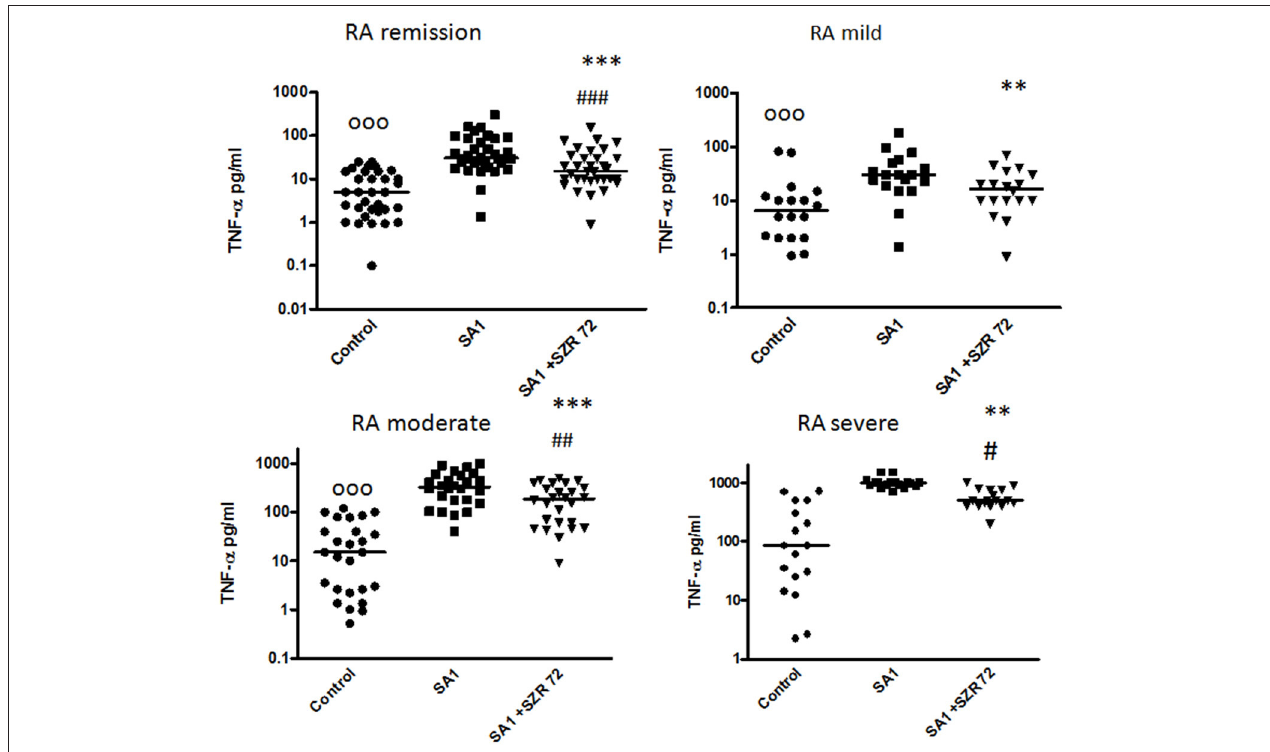
FIGURE 3 | The effect of SZR72 on tumor necrosis factor- α (TNF- α ) production in human whole blood cells of various groups of patients with RA stimulated by heat- inactivated Staphylococcus aureus. Each dot represents the individual value for one subject, and the horizontal lines denote the medians. Significance was determined by the Friedman’s test and Dunn’s post-test. Remission group: n = 30, p < 0.0001; control vs. SA1, significant, ooo p < 0.001; control vs. SA1 + SZR72, ### p < 0.001; SA1 vs. SA1 + SZR72, *** p < 0.001 according to the Dunn’s post-test. Mild group: n = 18, p < 0.0001; control vs. SA1, ooo p < 0.001; control vs. SA1 + SZR72, non-significant; SA1 vs. SA1 + SZR72, ** p < 0.01 according to the Dunn’s post-test. Moderate group: n = 27, p < 0.0001; control vs. SA1, ooo p < 0.001; control vs. SA1 + SZR72, ## p < 0.01; SA1 vs. SA1 + SZR72, *** p < 0.001. Severe group: n = 18, control vs. SA1, ooo p < 0.001; control vs. SA1 + SZR72, # p < 0.05; SA1 vs. SA1 + SZR72, ** p < 0.01 according to the Dunn’s